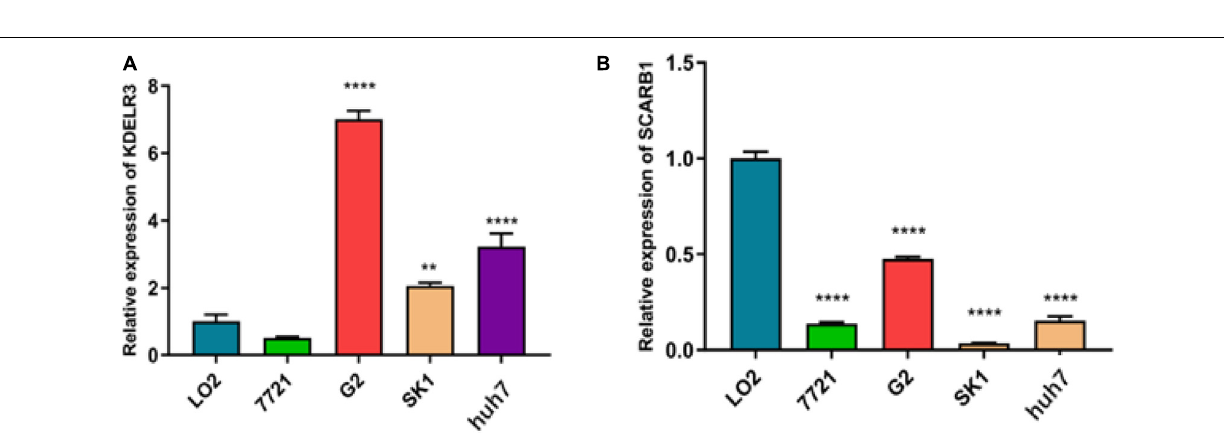
FIGURE 9 | Relative expression of KDELR3 (A) and SCARB1 (B) 7721 represent SMMC-7721,G2 represent Hep G2,SK1 represent SK-Hep-1 (** p < 0.0016,**** p < 0.0001).